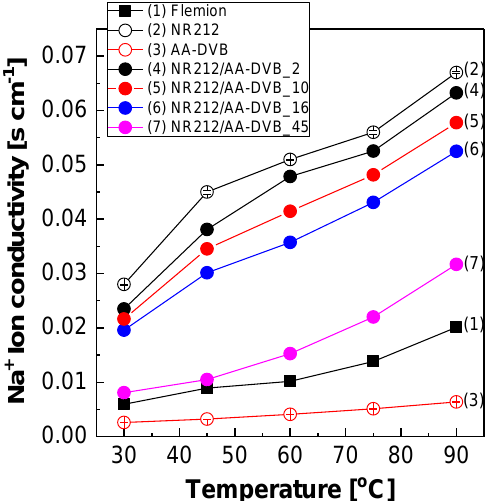
Figure 6. Na + ion conductivity of NR212/AA-DVB membranes as a function of